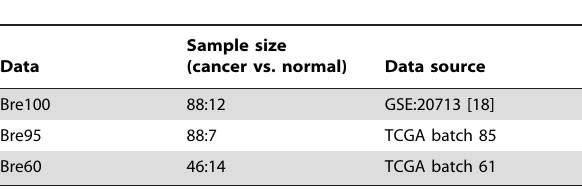
Table 1. The methylation data analyzed in this study.